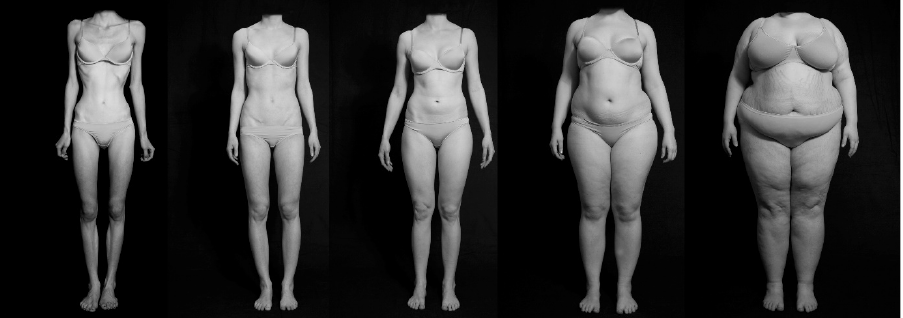
Figure 1. Stimuli of women’s bodies in five weight categories (from left to right: extremely under- weight, underweight, normal weight, overweight, and extremely overweight).